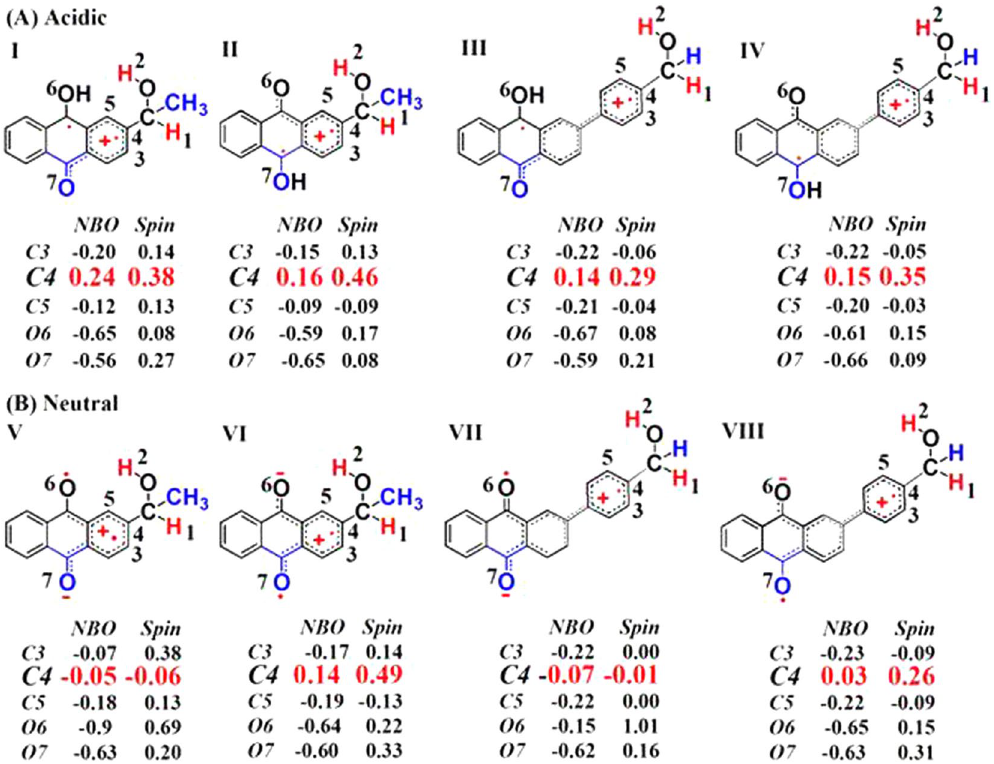
Figure 15. Shown are the NBO charge and spin density for HEAQ and PPAQ in acidic and neutral aqueous